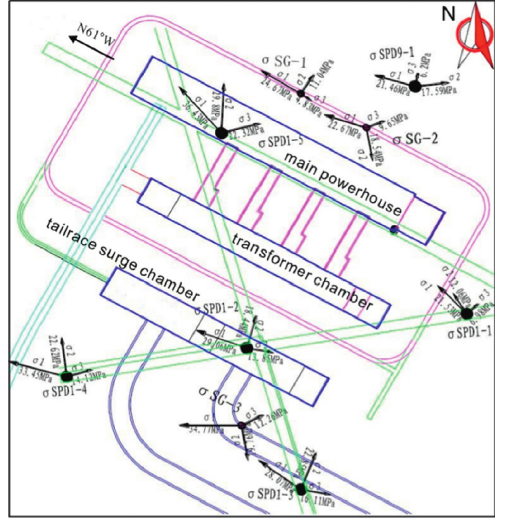
Figure 5: Distribution diagram of in situ stress measurement positions at the underground group cavern of Houziyan hydro- power station (modified after Dong et al.